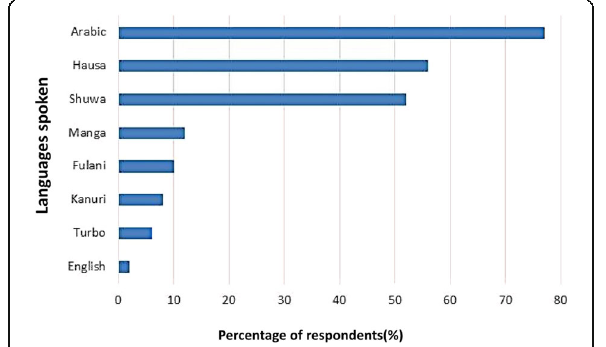
Figure 4 Languages spoken by camel-owning pastoralist in Northeastern